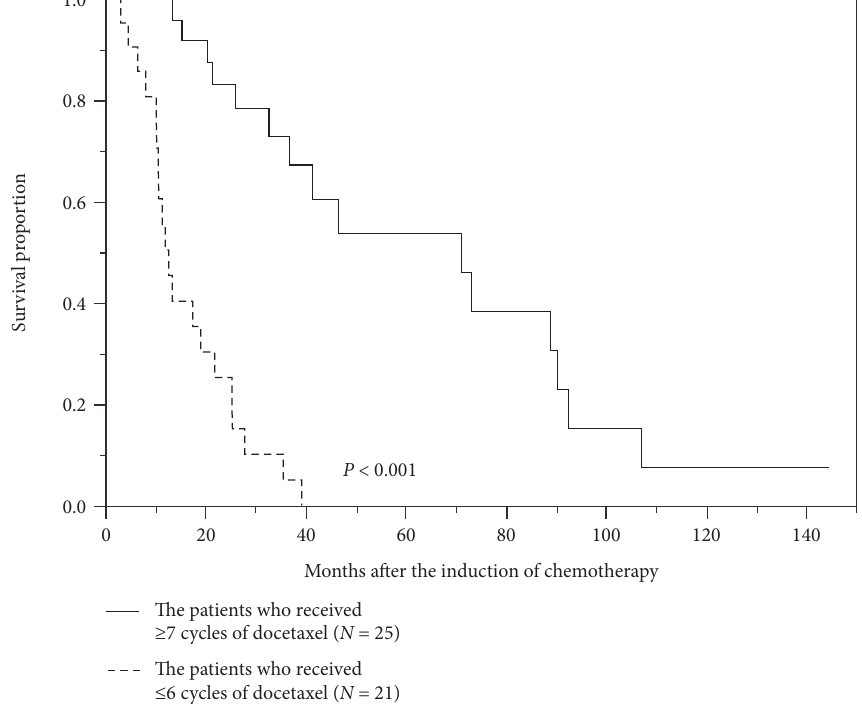
Figure 2: Kaplan–Meier estimate of overall survival (OS). The median OS in prostate cancer patients who received ≥ 7 cycles of docetaxel (DOC) followed by cabazitaxel (CBZ) was significantly longer than that in patients who received ≤ 6 cycles of DOC followed by CBZ ( P < 0 . 001 ) .